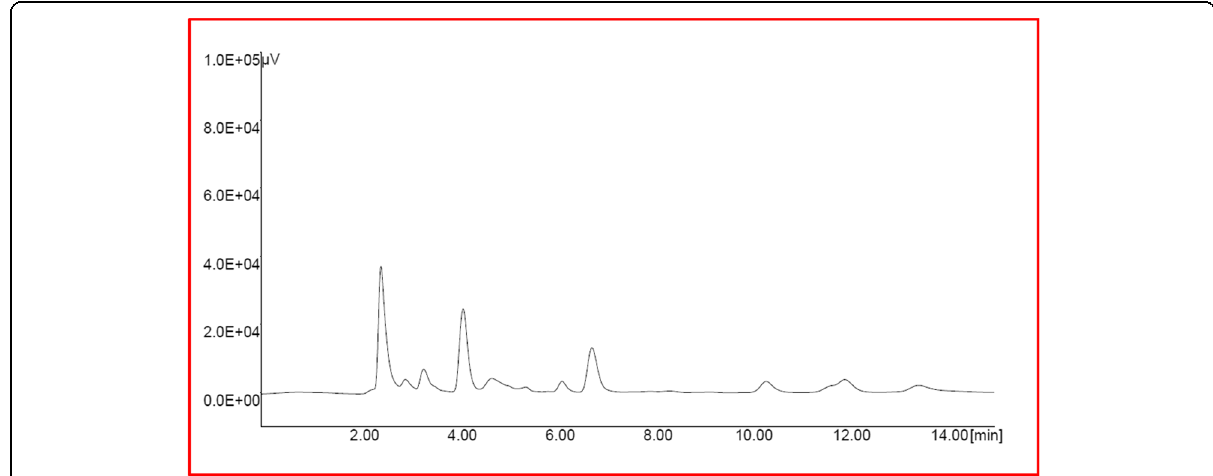
Fig. 2 Representative chromatogram of blank plasma